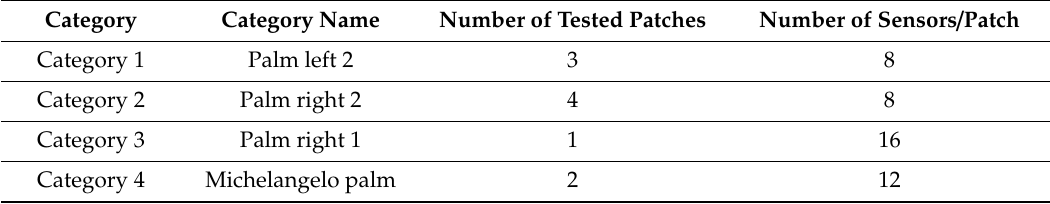
Figure 11. Compared categories (CAT1, CAT2, CAT3 and CAT 4) and heat map on the A3 fabrication substrate.( a ) Heat map of the fabrication and the selected categories for testing, ( b ) Zoom in view for each category’s location.